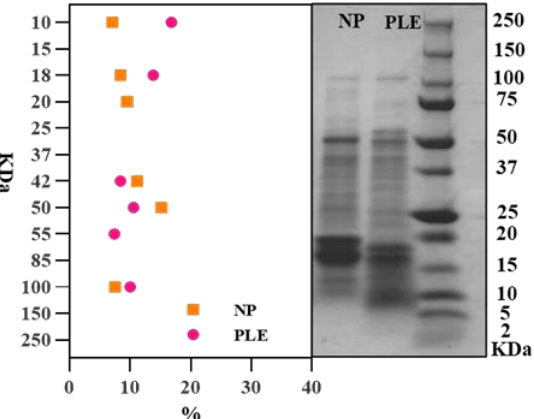
Figure 6. Protein molecular weight distribution of the extracts — SDS-PAGE.